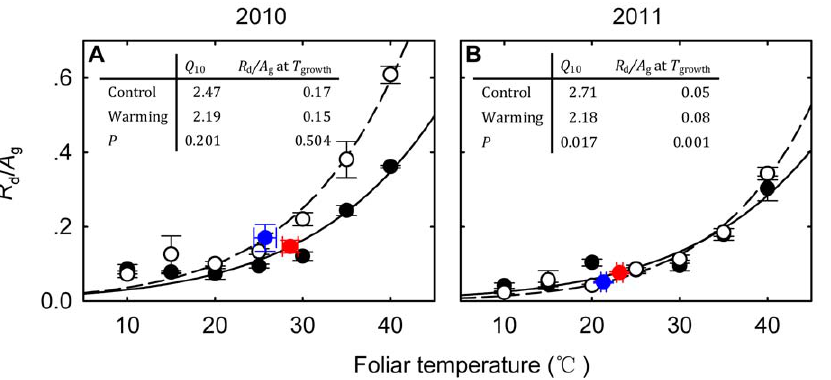
Figure 9. Warming effects on the response of R d / A g ratio (balance between dark respiration and gross CO 2 assimilation) to instantaneous change (10–40 6 C within a 5 h period) in T leaf (foliar temperature) in the dry growing season (2010) (A) and the wet growing season (2011) (B). The filled circles indicate the warming plots and the open circles for the control plots. The blue and red circles indicate R d / A g ratio at growth temperature ( T growth ), computed using the thermal dynamic properties (individual D H a and c values for each plot) and the